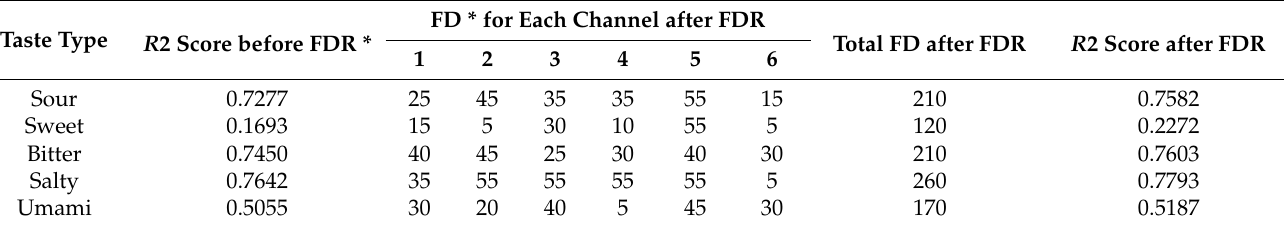
Figure 8. Relation between R 2 NF and NF for Sweet, Bitter, Salty, and Umami. For each taste type and each channel, datasets only containing features from this channel were constructed. NF is the number of features and R 2 NF is the R 2 score of SVM performed on a dataset containing NF features. The figure shows the trend of R 2 NF changed as the NF changed. The red circles are the curves’ chosen inflection points. Table 6. Results of the feature dimensionality